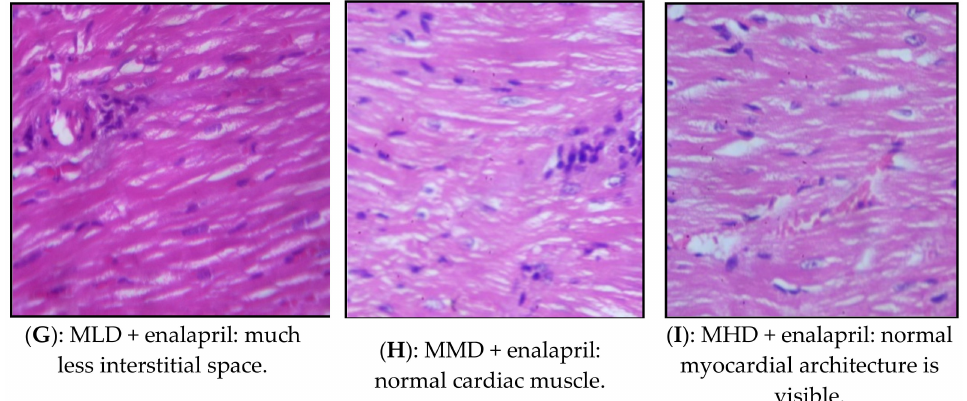
Figure 3. Hematoxylin and eosin ( H & E )-stained sections of the heart in ISO-induced myocardial damage in rats, photographed at a magnification of 400 ×